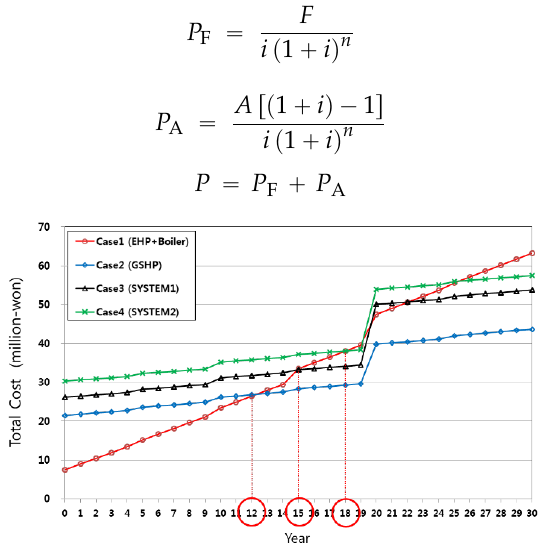
Figure 9. Life cycle cost results (All day, Seoul).